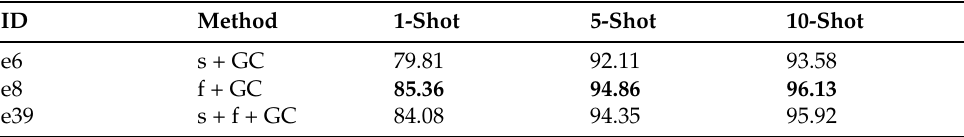
Figure 4. The network architecture of integrating spatial and frequency representations. Table 8. The results of integrating the spatial and frequency representations. ( f θ : Resnet12; data: setting-2; filter-size: 8 × 8; channel: top-24).